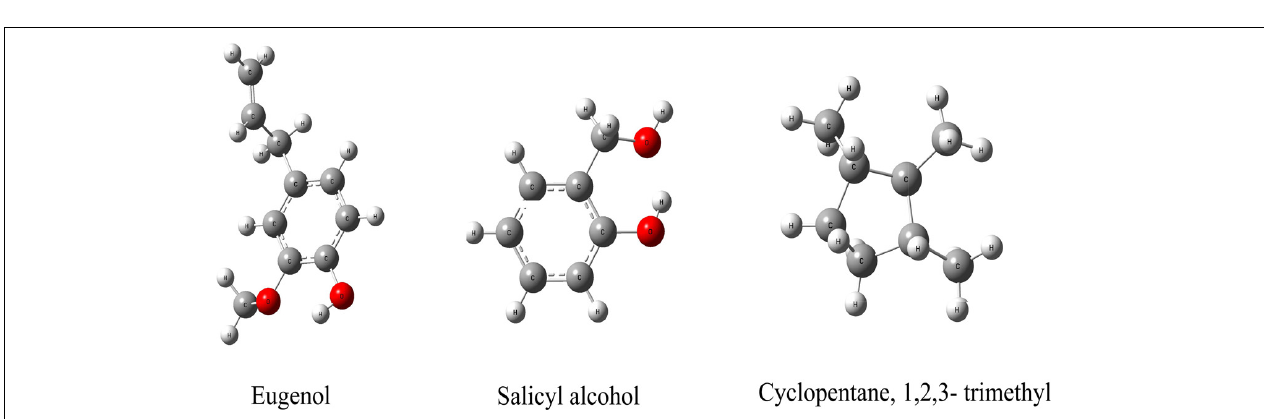
FIGURE 5 | The molecules from biochar that could interact with the HisG protein.